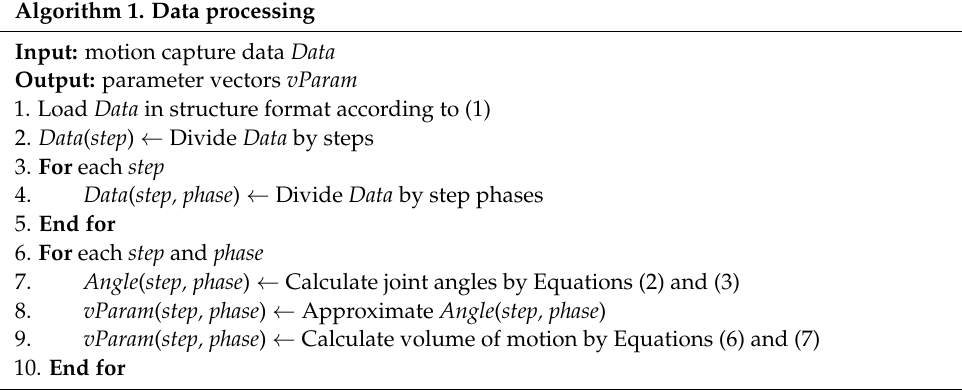
Algorithm 1. Data